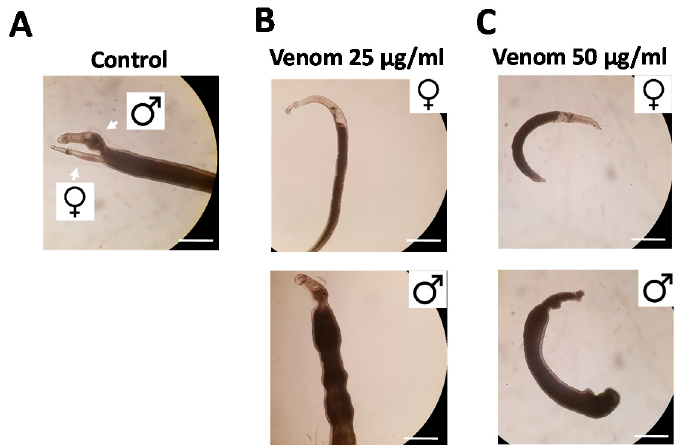
Figure 2. Rhynocoris iracundus venom a ff ects the vitality of Schistosoma mansoni . Worm pairs were treated with di ff erent concentrations of venom (25 or 50 µ g / mL). Representative images show worms after 72 h. ( A ) Untreated control worms remained paired and attached via their suckers to the base of the culture plate. The addition of venom at ( B ) 25 µ g / mL or ( C ) 50 µ g / mL induced the separation of pairs and detachment from the plate. Scale bars = 250 µm.